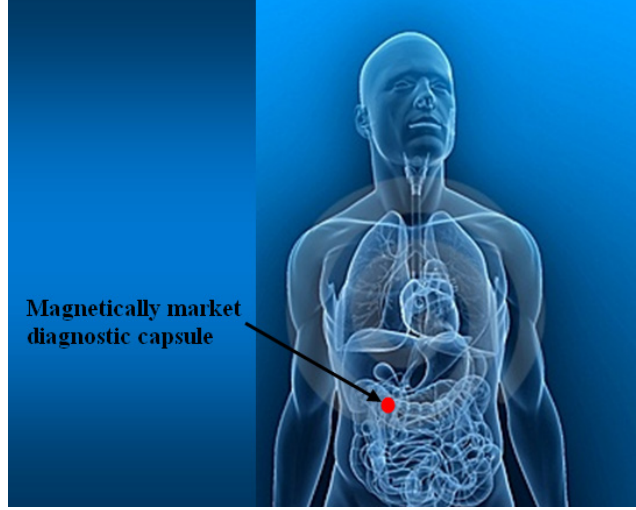
Figure 20. Future medical application of magnetic field sensors for visualizing magnetically market diagnostic